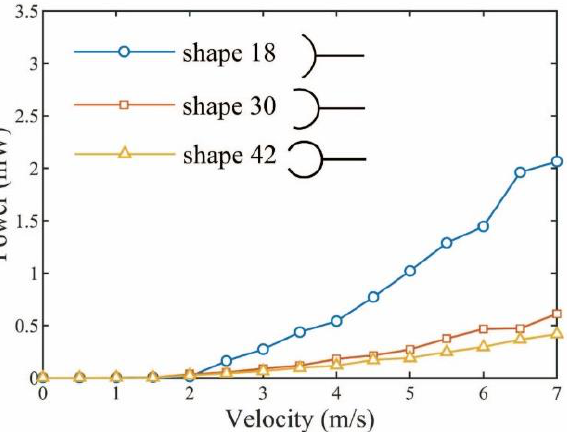
Figure 7. Variation of output power with wind velocity for WEHs with different arc angle bluff bodies.